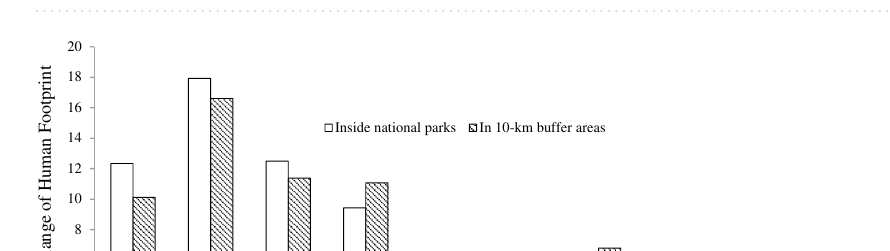
Figure 3. Human Footprint and land use in Manusela National Park, Maluku in 2017. Activity data maps of Manusela NP (land cover maps, roads, river and settlements) used in the Human Footprint analysis in this study were obtained from the Indonesian Ministry of Environment and Forestry 32 and Binamarga 33 and NP boundary was obtained from The World Database on Protected Areas (https ://www.prote ctedp lanet .net/en). The Maps were created using Esri ArcMap 10.8 (https ://www.arcgi s.com).